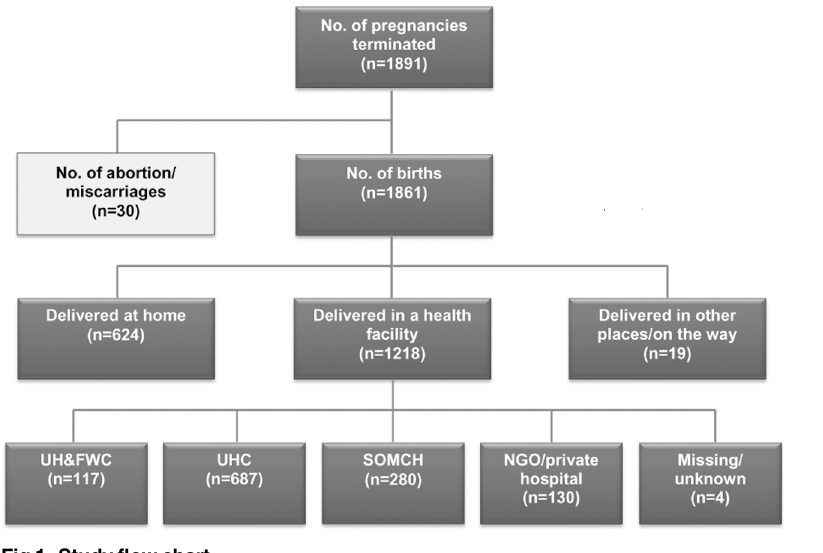
Fig 1. Study flow chart.